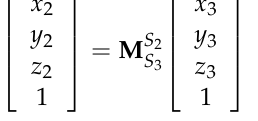
Figure 2. Schematic diagram of data registration and system calibration.